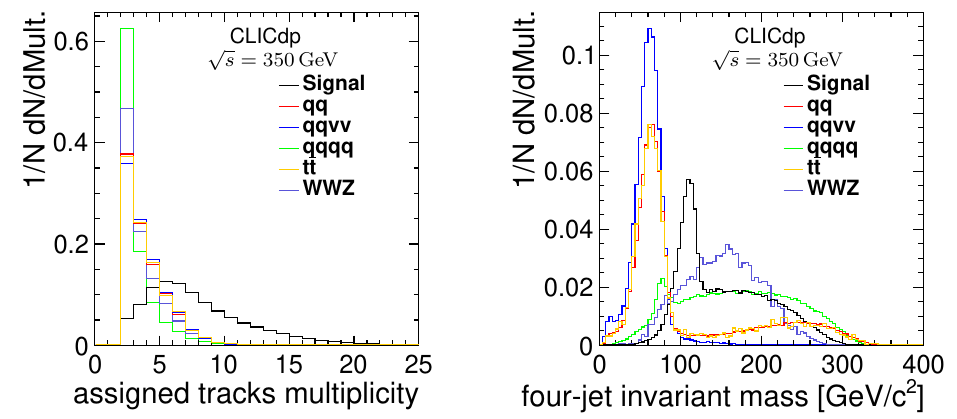
Figure 2 . Number of tracks assigned to the reconstructed DV (left) and four-jet invariant mass √ (right) for signal samples at s = 350 GeV with π 0 mass of 35 GeV/c 2 and the lifetime of 10 ps, v compared to q ¯ q , q ¯ qν ¯ ν , q ¯ qq ¯ q , t ¯ t and WWZ background events.